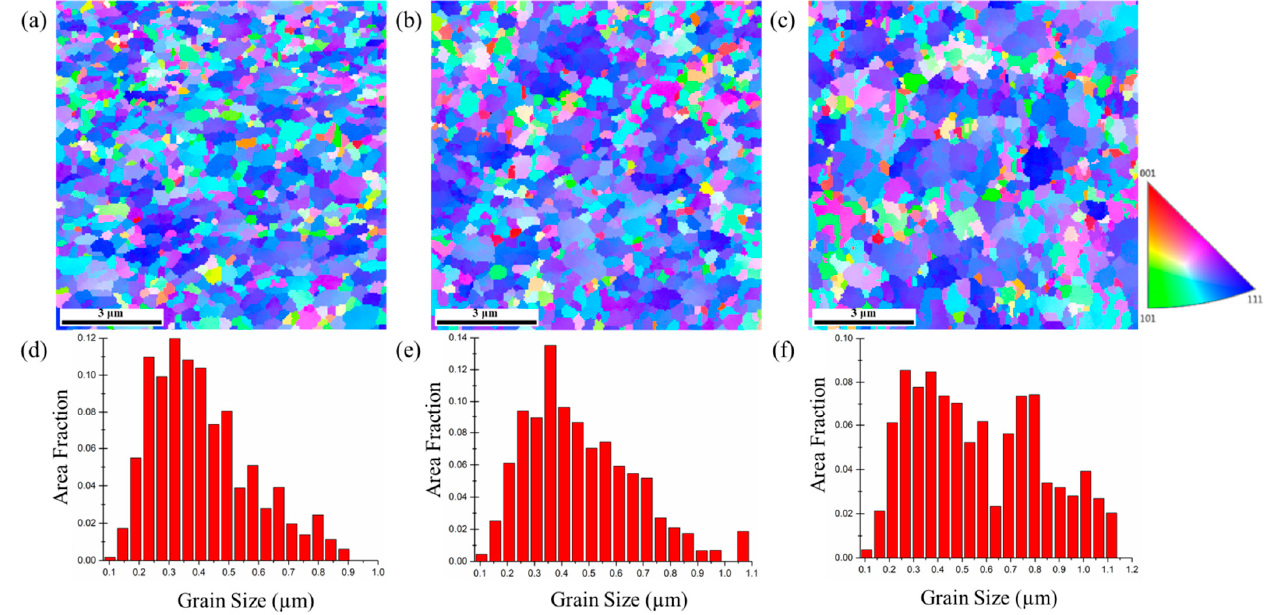
Figure 5. Plan-view EBSD micrographs and grain size distributions of the 5- μ m thick nt-Cu foils electroplated with dif- ferent concentrations of Cu 2+ : ( a , d ) 0.3 M; ( b , c ) 0.5 M; ( c , f ) 0.8 M, respectively.